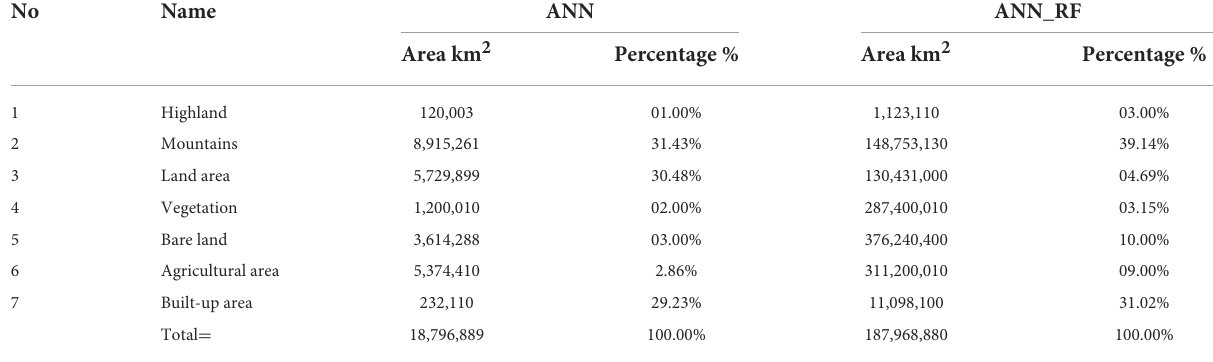
TABLE 4 Area and percentages LULC for ANN and (ANN_RF) to Sentinel-2A satellite.